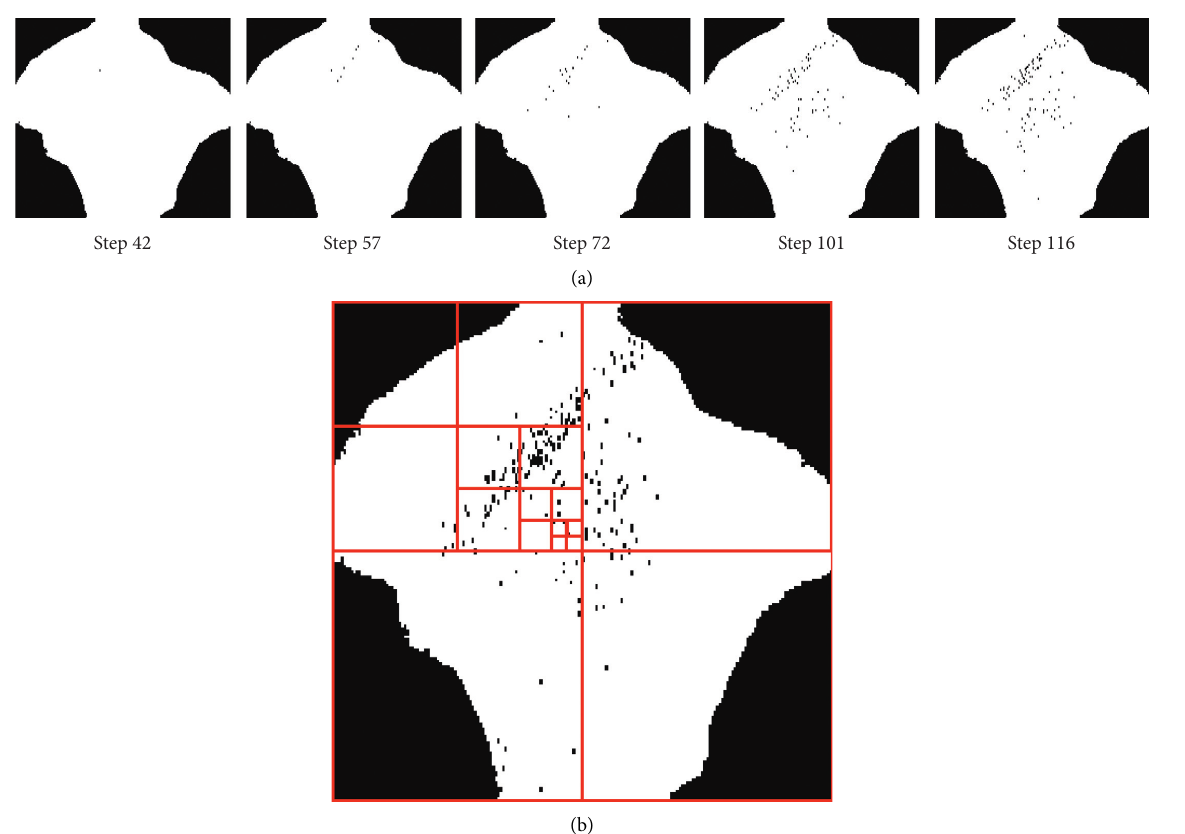
Figure 3: The calculation process of the box dimension of the rock mesodamage area. (a) Damage evolution of sandstone particles in the form of a binary image (with confinement). (b) Schematic diagram of the box division